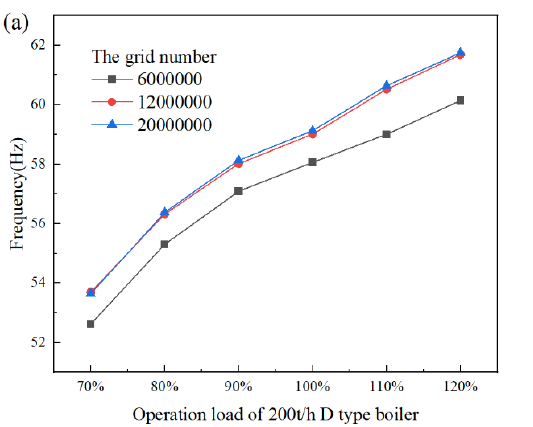
Figure 3. Block mesh of the convection bank in a D-type boiler: ( a ) Study on grid Independence; ( b ) Study on time step.